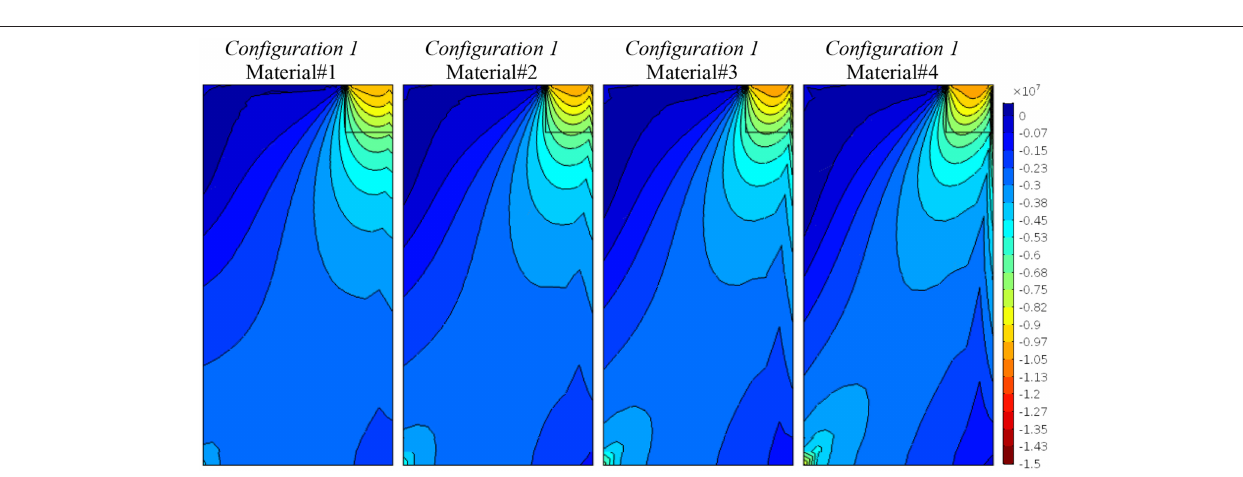
FIGURE 3 | Configuration 1, vertical stress component, σ 22 , contour plots for four material cases (Material#1/Material#4 minimum/maximum anisotropy